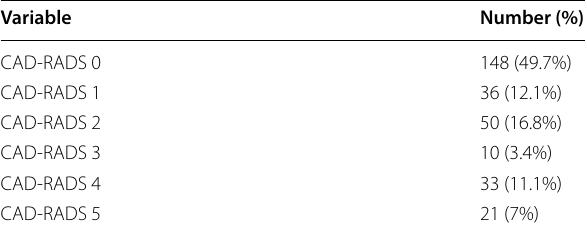
Table 4 CAD severity according to the Society of Cardiovascular Computed Tomography (SCCT)